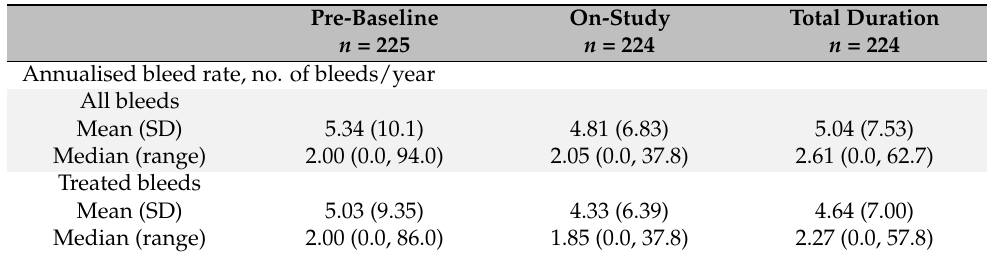
Table 2. Pre-baseline and on-study annualised bleeding rates of the 6-Month Analysis